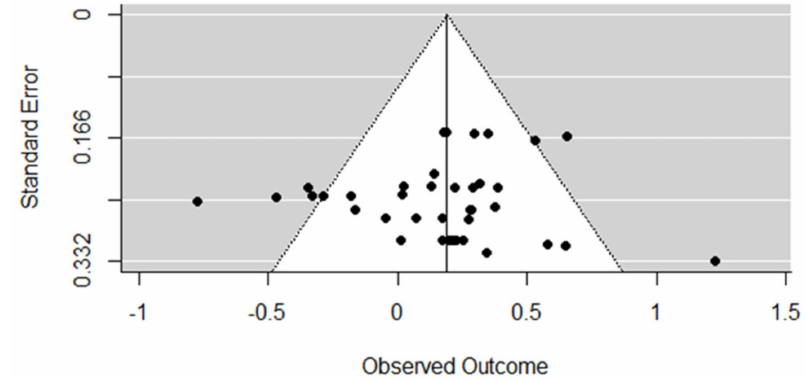
Figure 3. Funnel plot for effect sizes (g) synthesis.